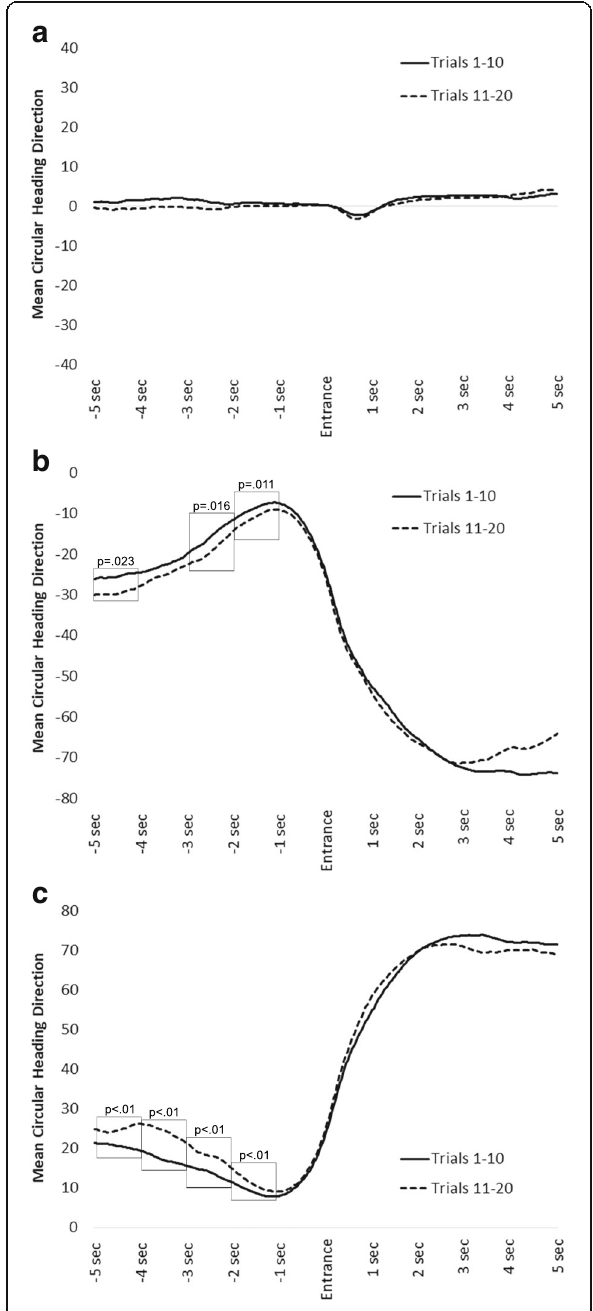
Fig. 3 a – c Mean circular heading direction for the two Trial Sets (trials 1 – 10 vs 11 – 20) and 10 time bins (five preceding and five following an intersection entrance). 0 degrees indicates north heading. Data are depicted for all instances when a wayfinder continued straight ( a ), turned left ( b ), and turned right ( c ). Significant differences within examined time bins are indicated by rectangles with associated p